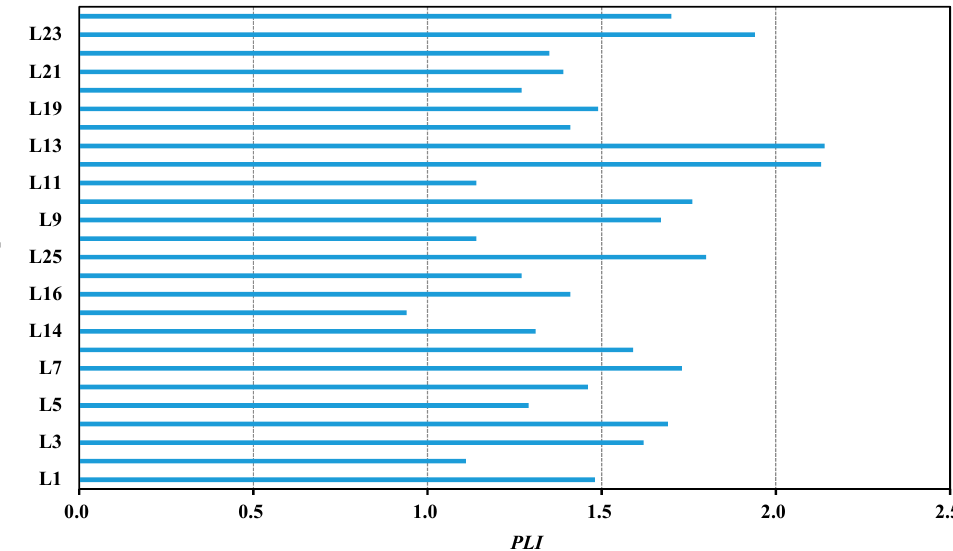
Figure 3. PLI values of heavy metals in dust samples collected from parks and squares of Baotou.